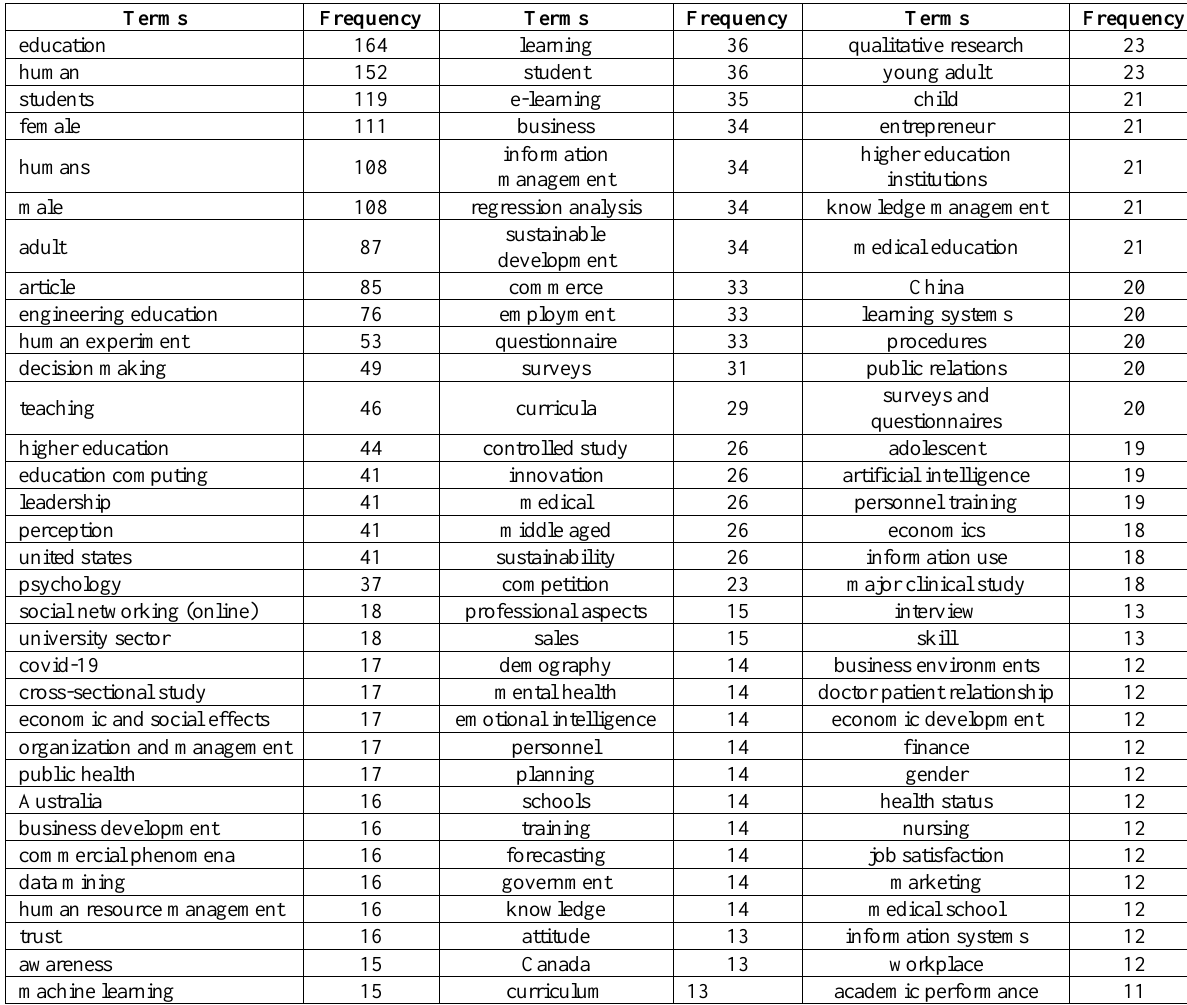
Table 3. Frequency of Use of 100